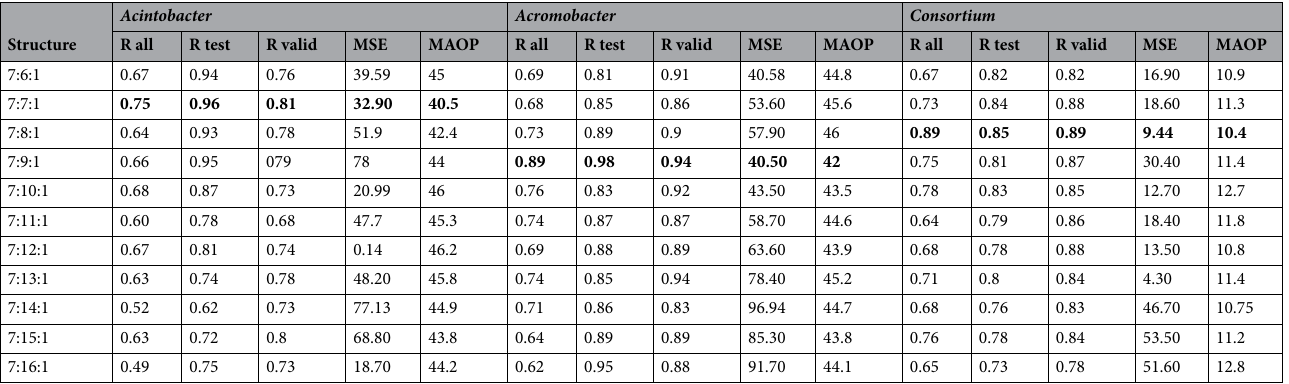
Table 3. Performance of the artificial neural network during changes in the number of neurons in the lattice. Significant values are in bold. Values are in bold (maximum and minimum response levels).